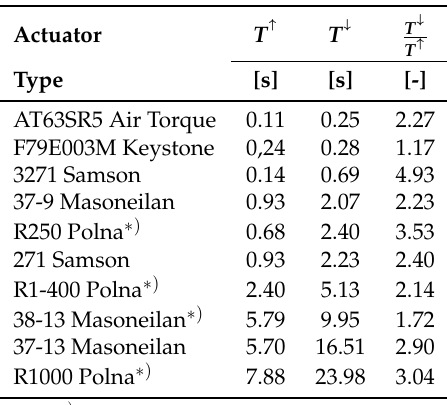
Table 2. Parameters of the effective transmittance of the assembly: pneumatic actuator and electro-pneumatic